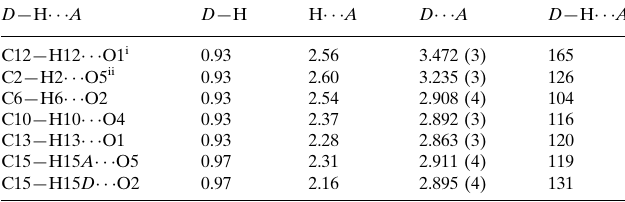
Hydrogen-bond geometry (A˚ , (cid:1)